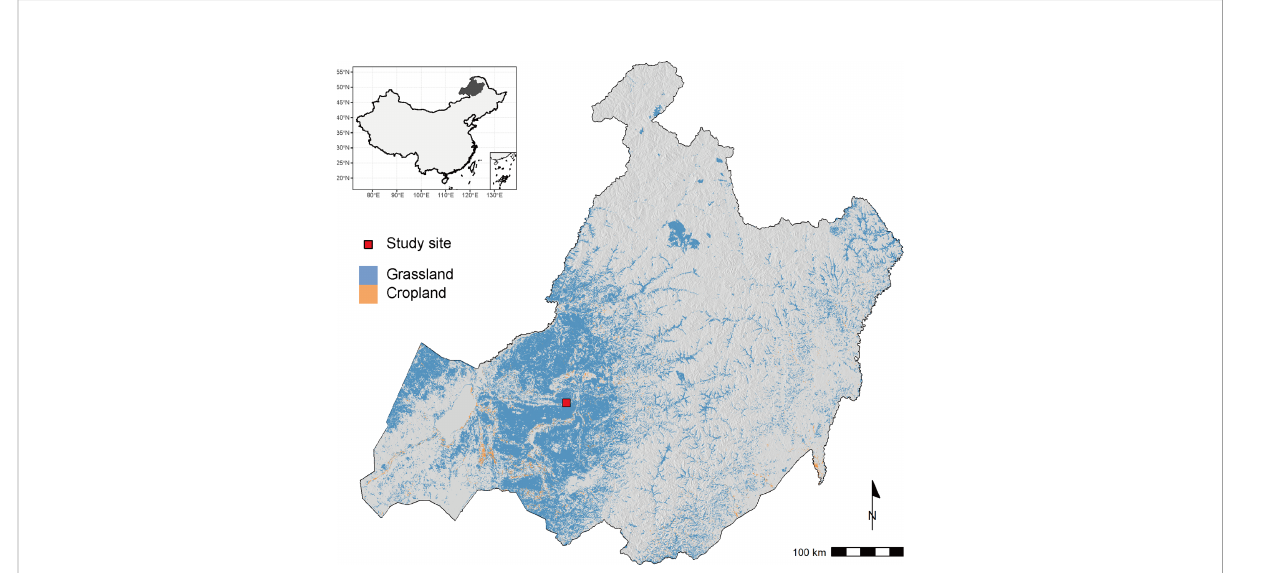
FIGURE 1 The location of the study site in relation to the regional distribution of grasslands and croplands, which are extracted from ESA CCI land cover v2.0.7 for the year 2015. The underlying terrain is created based on NASA ’ s SRTM